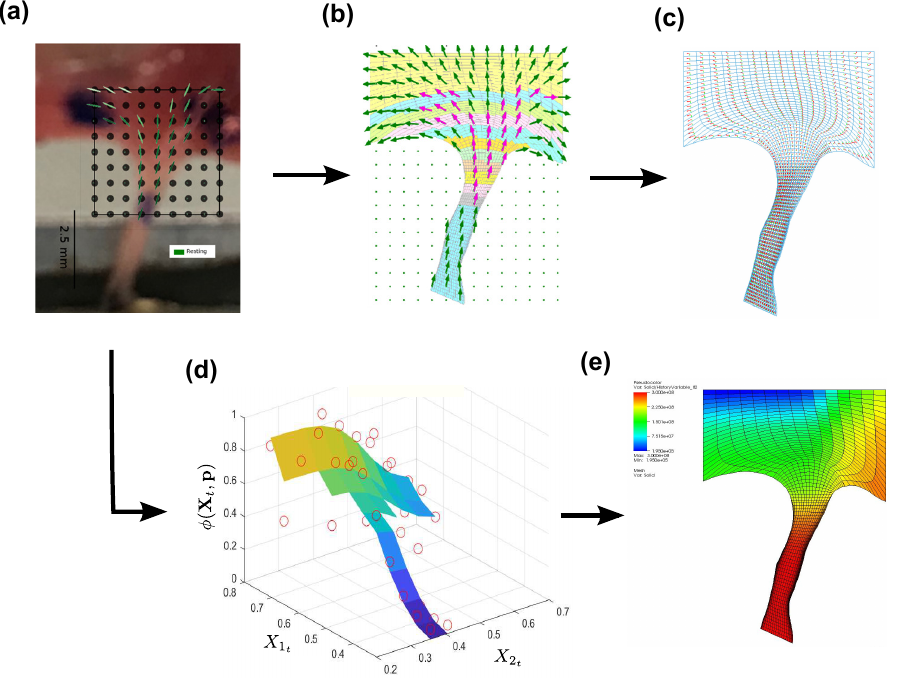
Figure 6. FGM model setup in CT–LL transition of TV. ( a ) XRD diffraction imaging producing fiber orientation and collagen intensity at grid points in the transition region, ( b ) fiber orientations mapped to a virtual matched pair finite element (FE) model, ( c ) fiber orientations assigned to the mesh on a per-element basis, ( d ) normalized intensity overlaid with fitted distribution function φ ( X t , p ) and ( e ) functionally graded parameter C 1 assigned on a per-element basis to the mesh using φ ( X t , p ) in ( d ). Scale bar in ( a ) represents 2.5